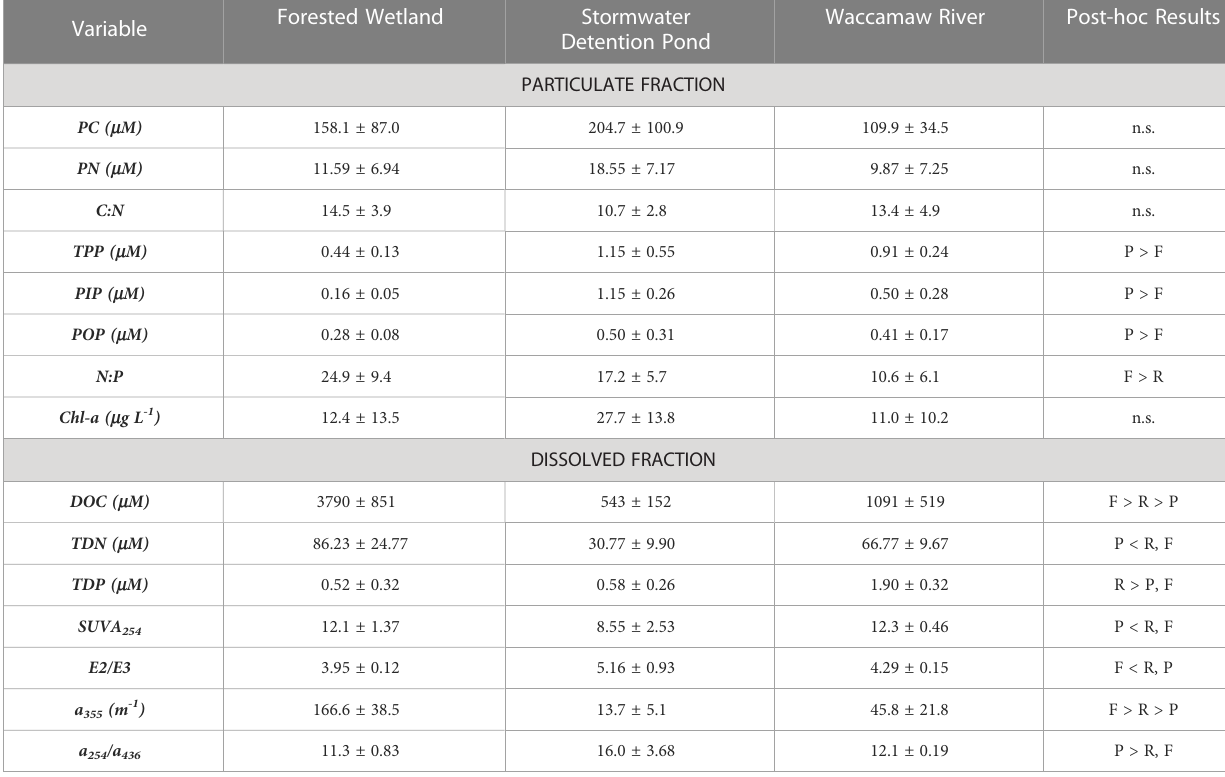
TABLE 2 Overview of average ambient conditions for each site